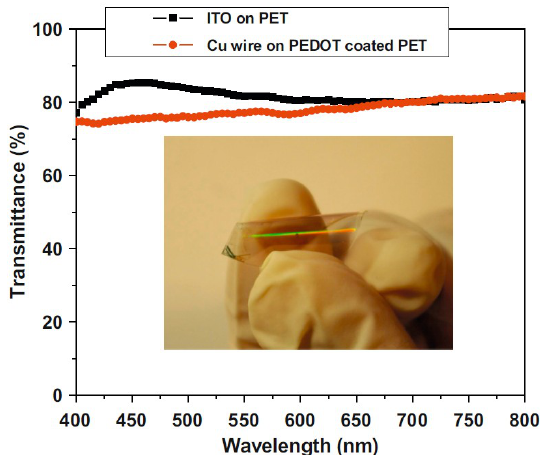
Figure 12. Optical transmittance of Cu NW thin film on PEDOT-coated PET substrate and commercial ITO thin film on PET substrate (inset photo shows the flexibility of the Cu NW thin film on PEDOT-coated PET substrate). Reproduced with permission from [42]. Copyright 2010 Elsevier Publishing. Table 2. Summary of different deposition methods and properties of Cu NW coatings and thin films. Ref.